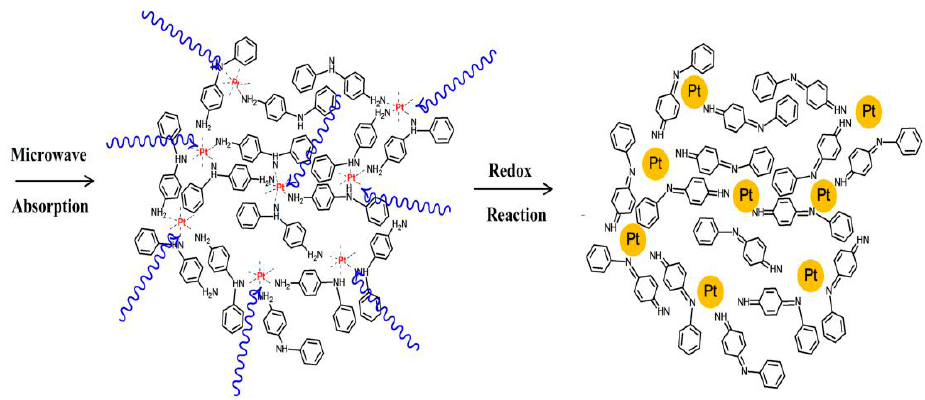
Scheme 1. Schematic diagram of the microwave-assisted redox reaction between PPDA and XC72.